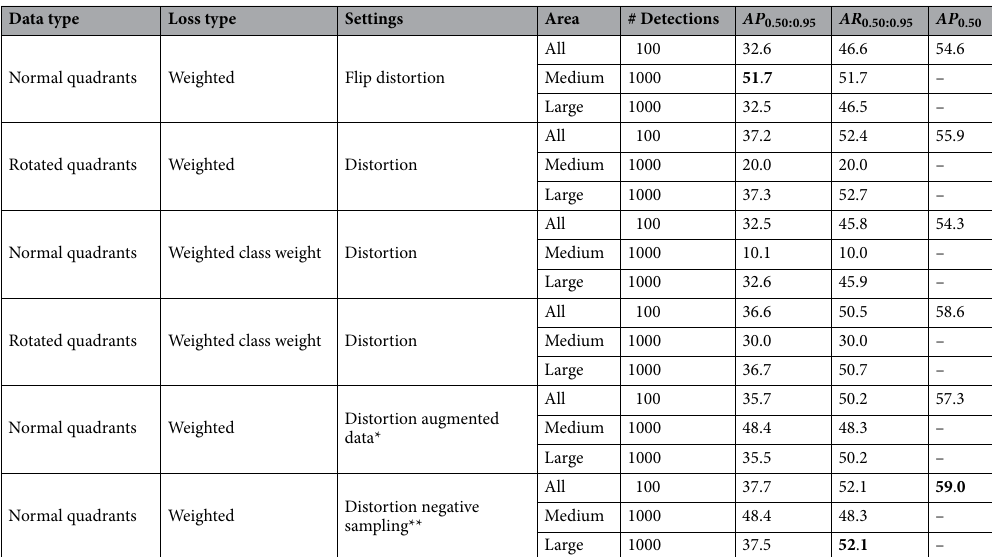
Table 4. Object detection metrics of the treatment detection task on the test quadrant dataset. AP 0.50 : 0.95 : Average precision of bounding boxes that have an IoU between 50% and 95 %. AR 0.50 : 0.95 : Average recall of bounding boxes that have an IoU between 50% and 95%. All scores are written as a percentage. The highest scores are highlighted in bold. *Augmented images of rare classes are added before training. **Used all quadrant images even if they do not contain any